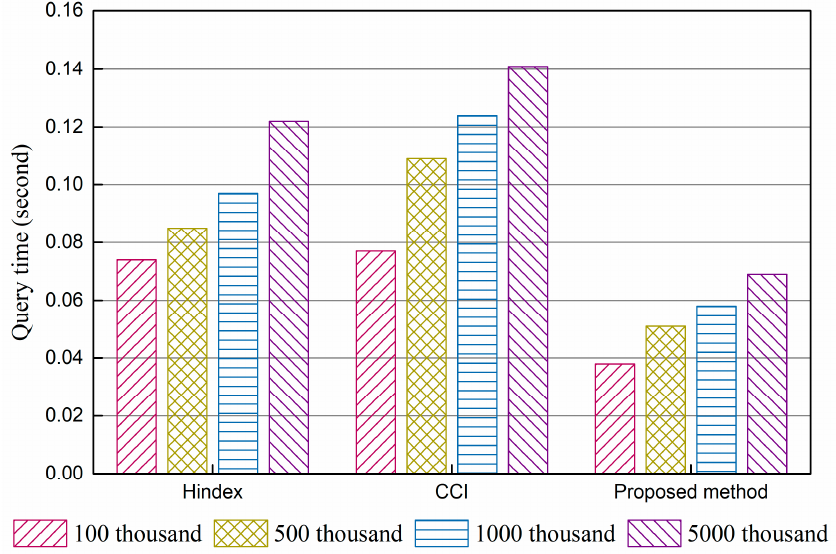
Figure 5. Results of Multi-column query performance experiment.